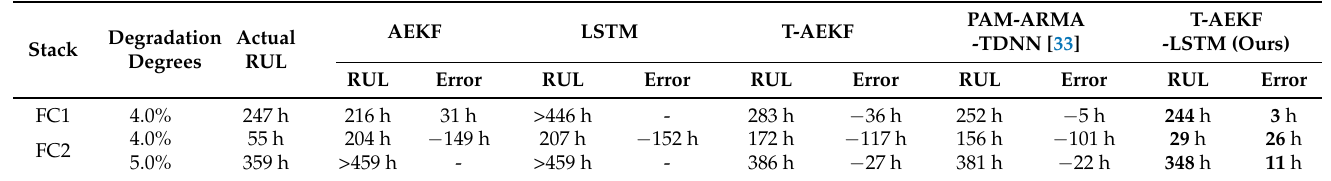
Table 5. The RUL prediction results for FC1 and FC2 (55% training